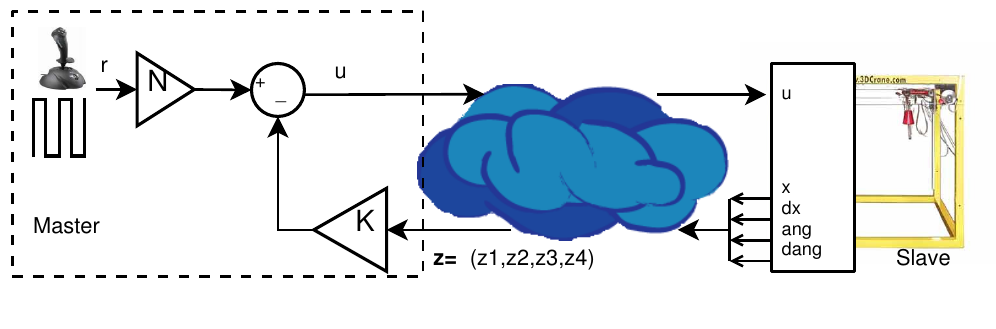
Figure 7. Tele-operated gantry